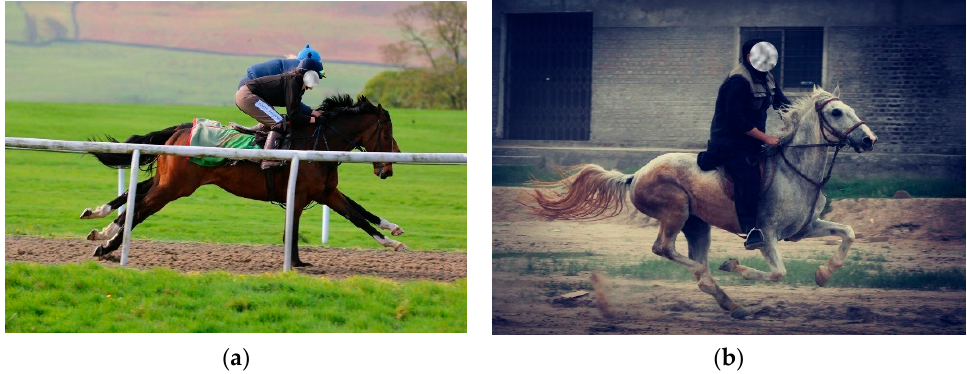
Figure 2. Horses with their riders: ( a ) A horse and a rider with BWR 11.96% in the UK. Photo: Mick Atkins; ( b ) A horse and a rider with BWR 24.21% in Faisalabad, Pakistan. Photo: Sabir Hussain.